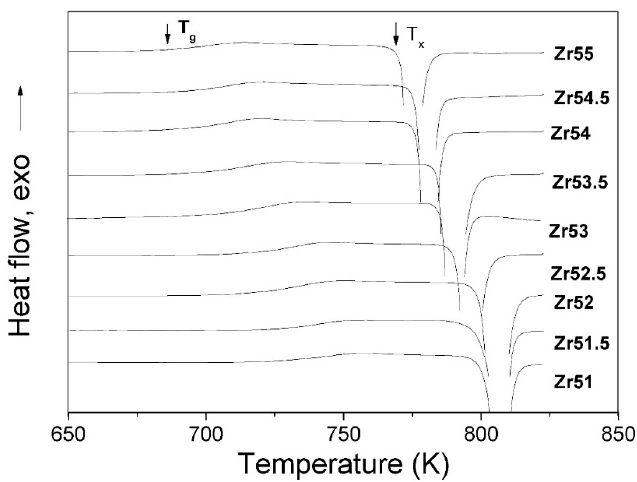
Figure 4. DSC curves of all studied Zr-based BMGs at a heating rate of 30 K ∙ min − 1 .